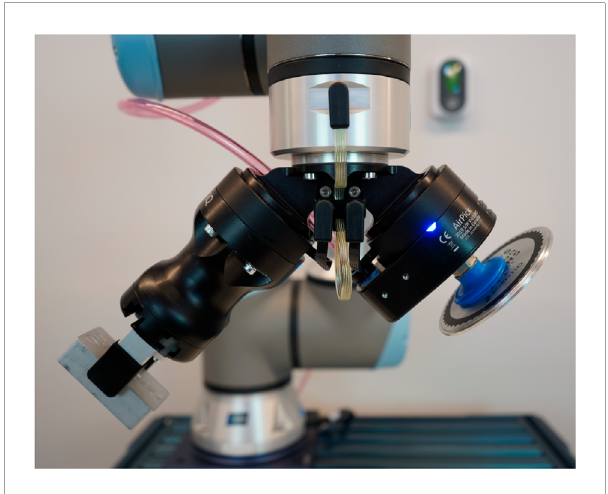
FIGURE 1 Image source: Robotiq Inc., 2022. Used with permission. The Dual-Grip system with the Hand-E and the AirPick